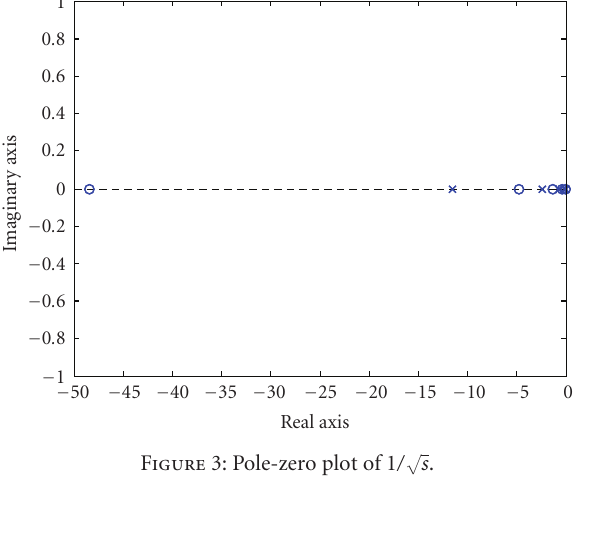
Figure 3: Pole-zero plot of 1 /